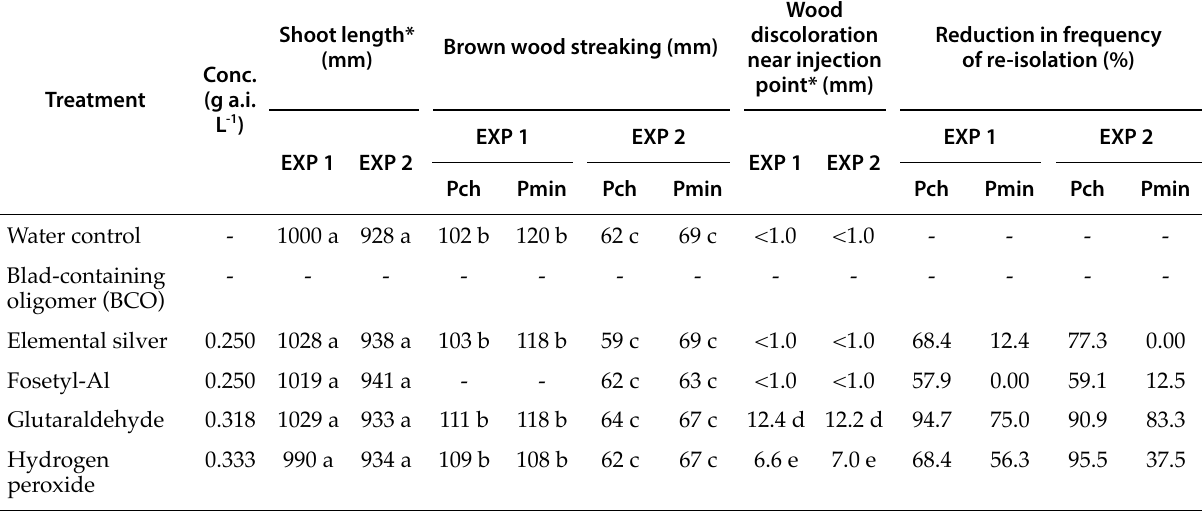
Table 2. Mean shoot lengths, extents of brown wood streaking and wood discolouration, and reductions in frequencies of pathogen re-isolation, after injection of different chemicals into rooted grapevine cuttings (cv. Touriga Nacional) that had been inoculated with Phaeomoniella chlamydospora (Pch) or Phaeoacremonium minimum (Pmin).